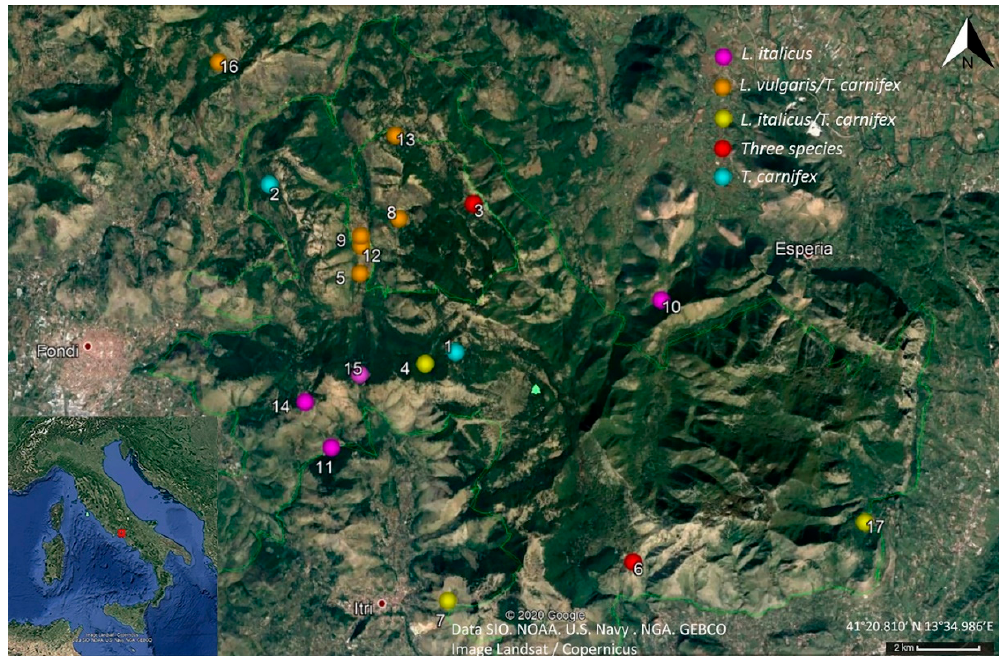
Figure 1. Map illustrating the distribution of the study wells and the newt species with indication of species coexistence. The numbers on the map refer to the well ID (see Table S1) (Google Earth, earth.google.com/web/).